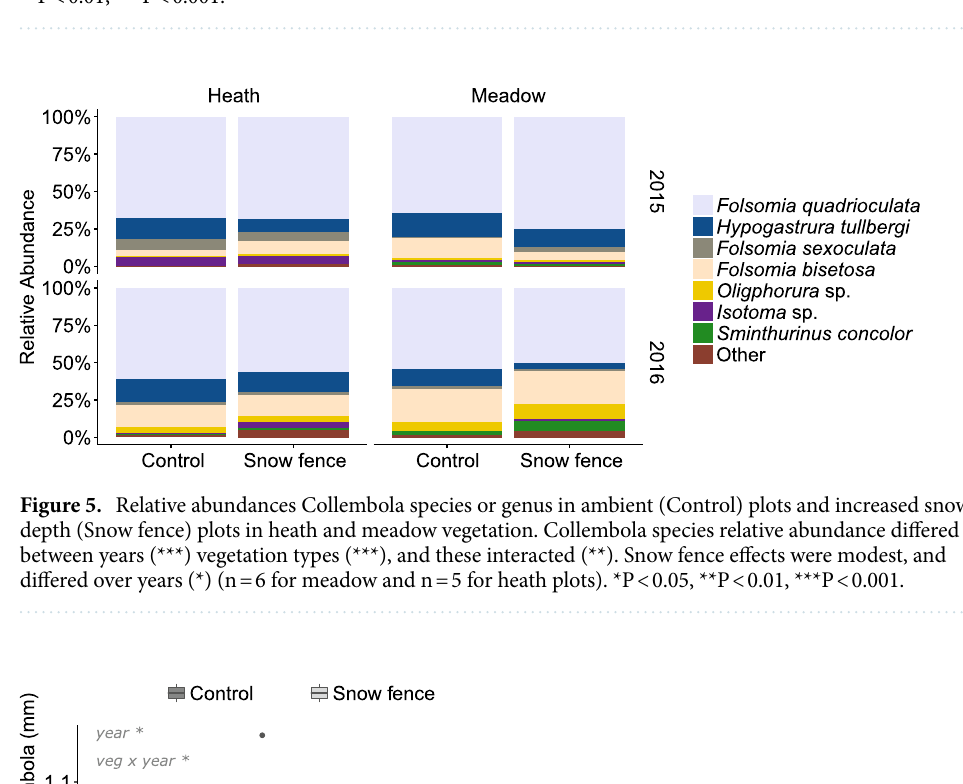
Figure 4. Relative abundances of microarthropod groups in unmanipulated, ambient (Control) plots and increased snow depth (Snow fence) plots in heath and meadow vegetation. Community composition differed between sampling years (***) and was affected by vegetation type (***), but increased snow depth only modestly changed relative abundances and differently over years (*) (n = 6 for meadow and n = 5 for heath plots). *P < 0.05, **P < 0.01, ***P < 0.001.